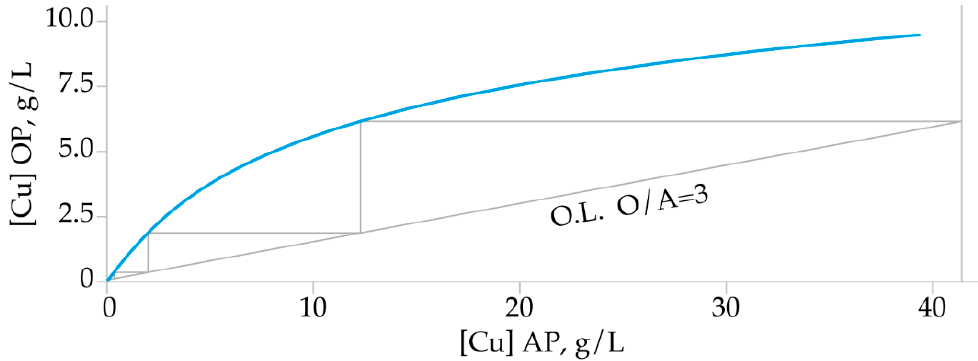
Figure 6. McCabe-Thiele extraction diagram.